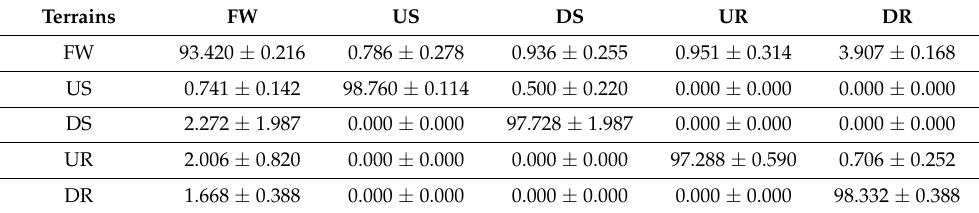
Table 5. Confusion matrix (MEAN ± SEM) for experimental results of FSM-SVM